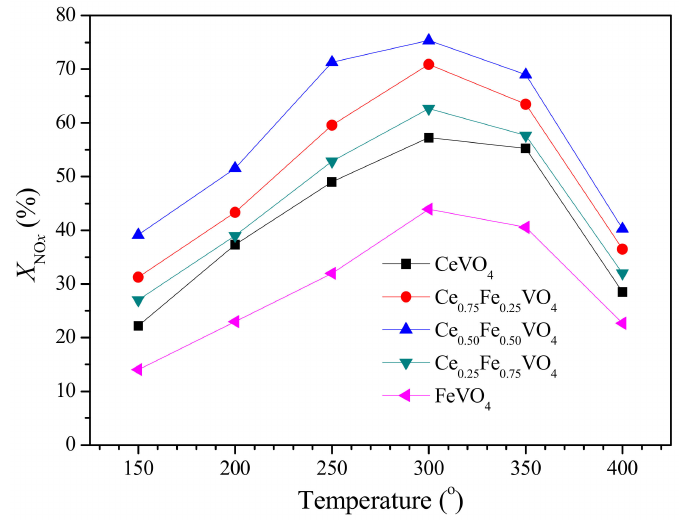
Figure 1. X NO x over Ce 1 − x Fe x VO 4 catalysts prepared by a hydrothermal method. Reaction condi- tions: [NO] = 500 ppm, [NH 3 ] = 500 ppm, [O 2 ] = 3 vol.%, balance N 2 ; catalyst weight: 200 mg; total flow rate: 1000 mL · min − 1